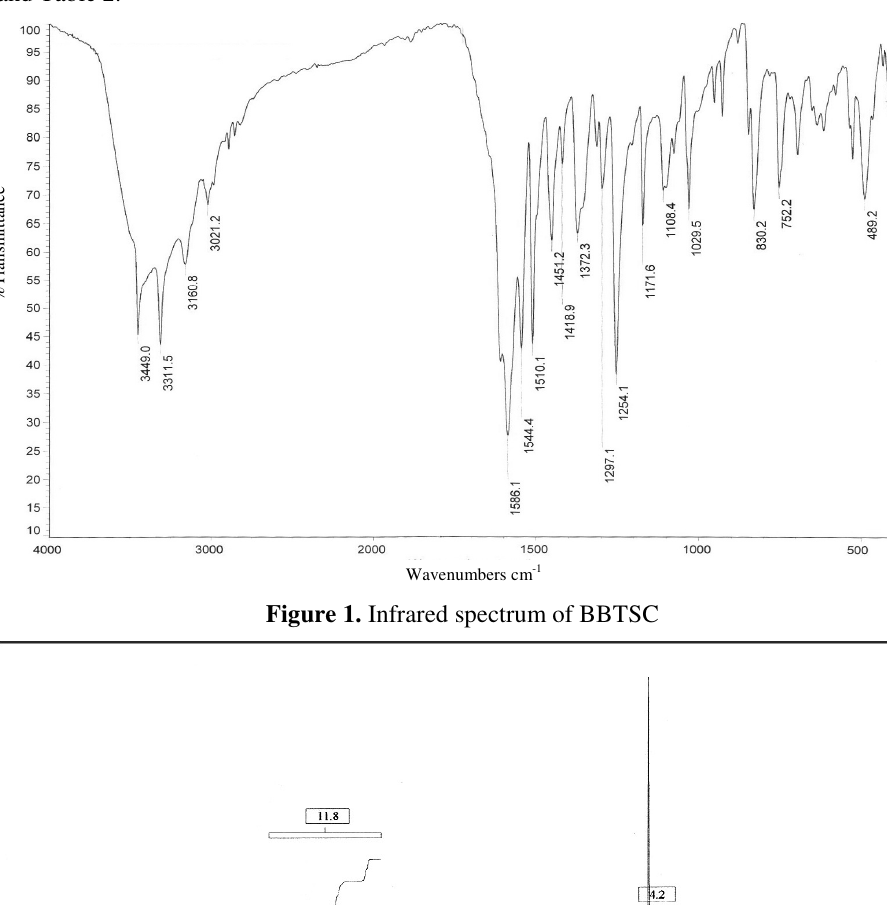
Figure 1. Infrared spectrum of BBTSC